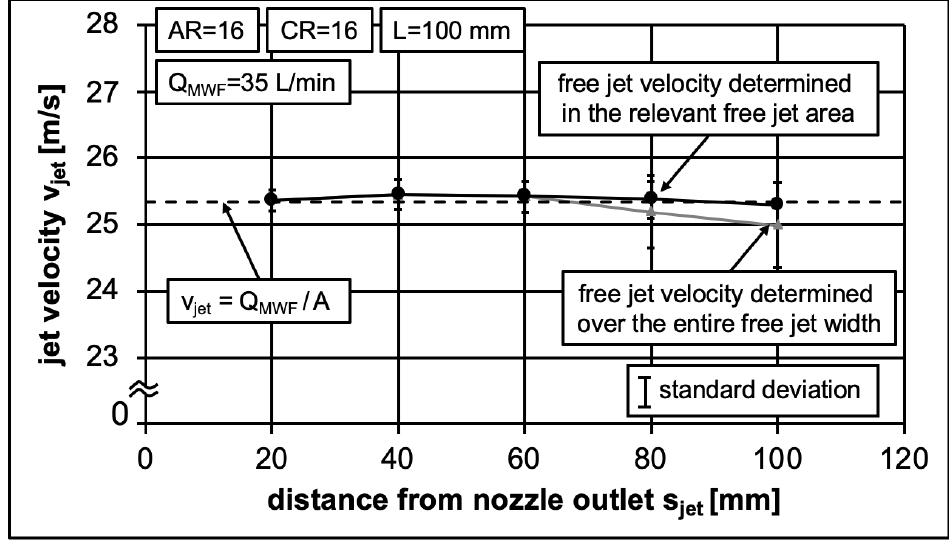
Figure 10. Jet velocity in the relevant free jet area and over the entire free jet width for different distances from nozzle outlet s jet .